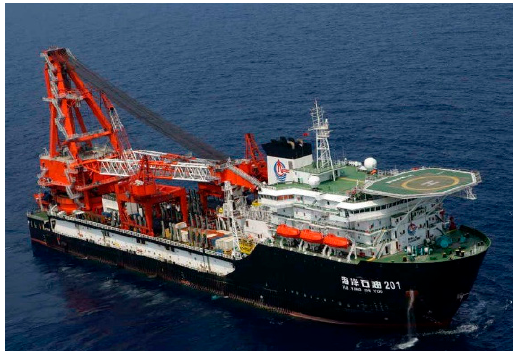
Figure 2. The HYSY201 operating at sea.